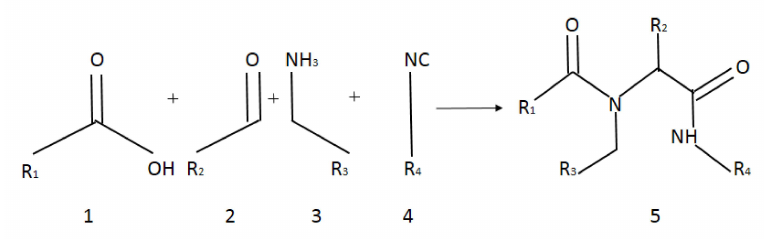
Figure 2. Scheme of Ugi reaction.